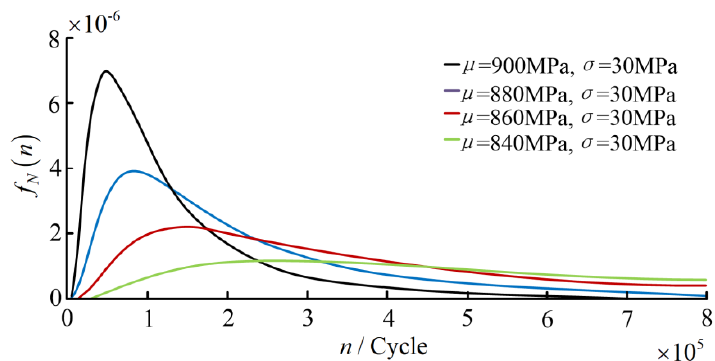
Figure 6. Fatigue life distribution affected by mean stress.